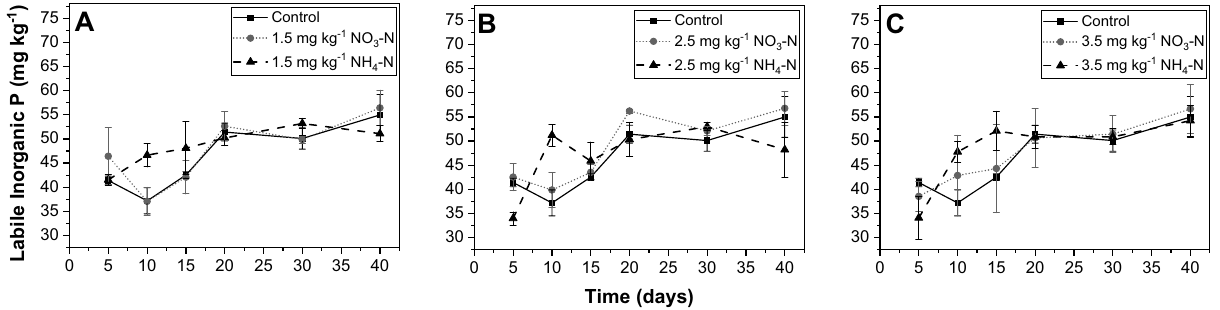
Figure 2. Labile inorganic P over the course of 40-day incubation, as a function of N species and amendment rate: ( A ) 1.5 mg kg −1 , ( B ) 2.5 mg kg −1 , and ( C ) 3.5 mg kg −1 . All analyses were conducted in triplicate. The error bars indicate the standard